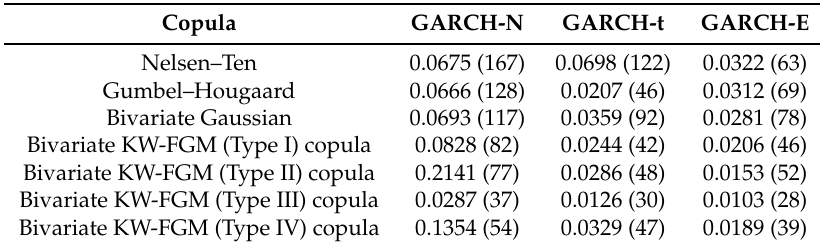
Table 2. Proportion of observations (number of observations in brackets), for t = 751 to 2971, where the portfolio loss exceeded the estimated Value at Risk for α = 0.05.